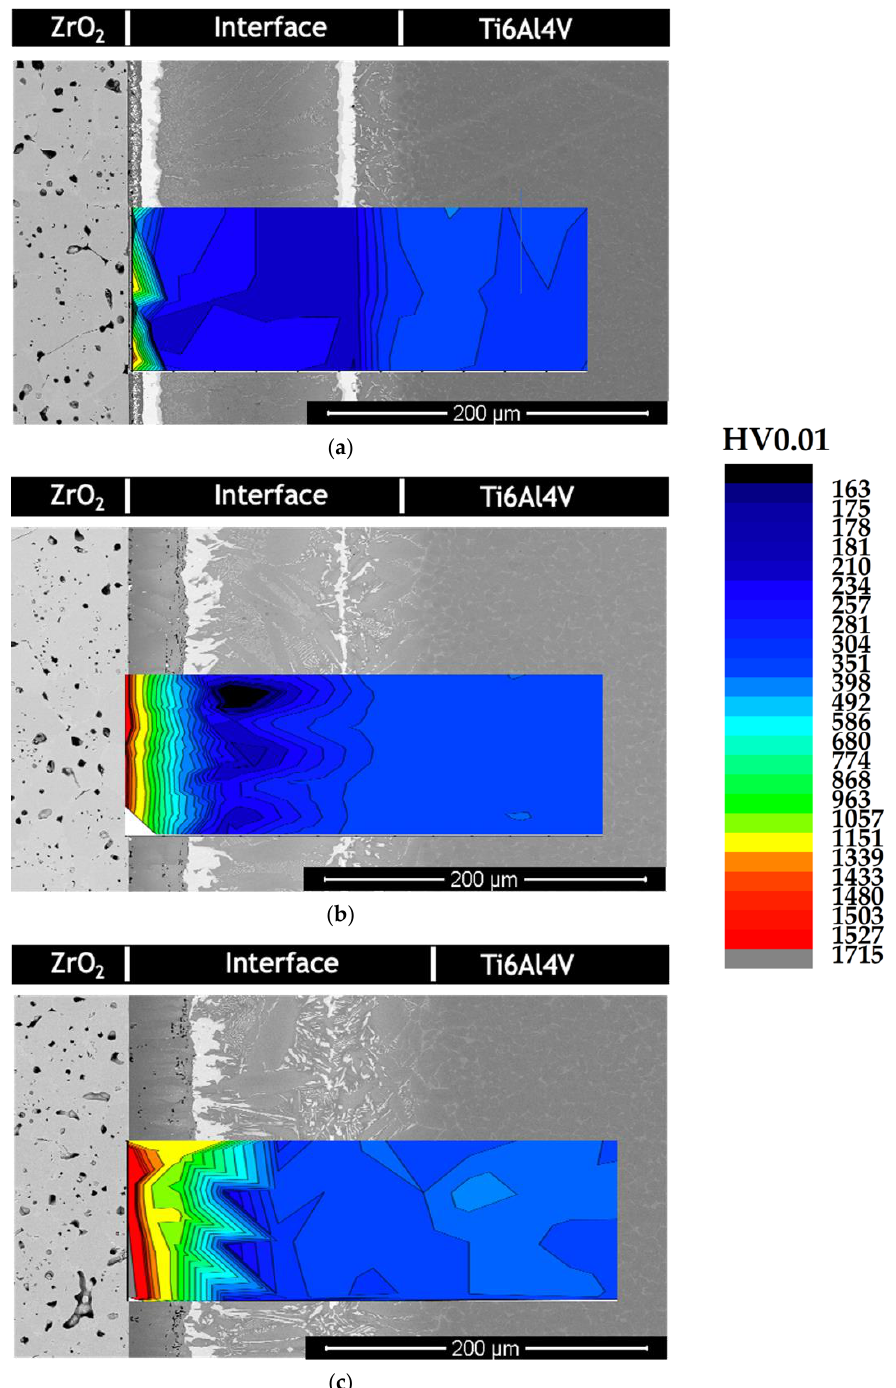
Figure 7. SEM image and hardness distribution maps of the joints processed at ( a ) 900 °C, ( b ) 950 °C, and ( c ) 980 °C. and ( c ) 980 ◦